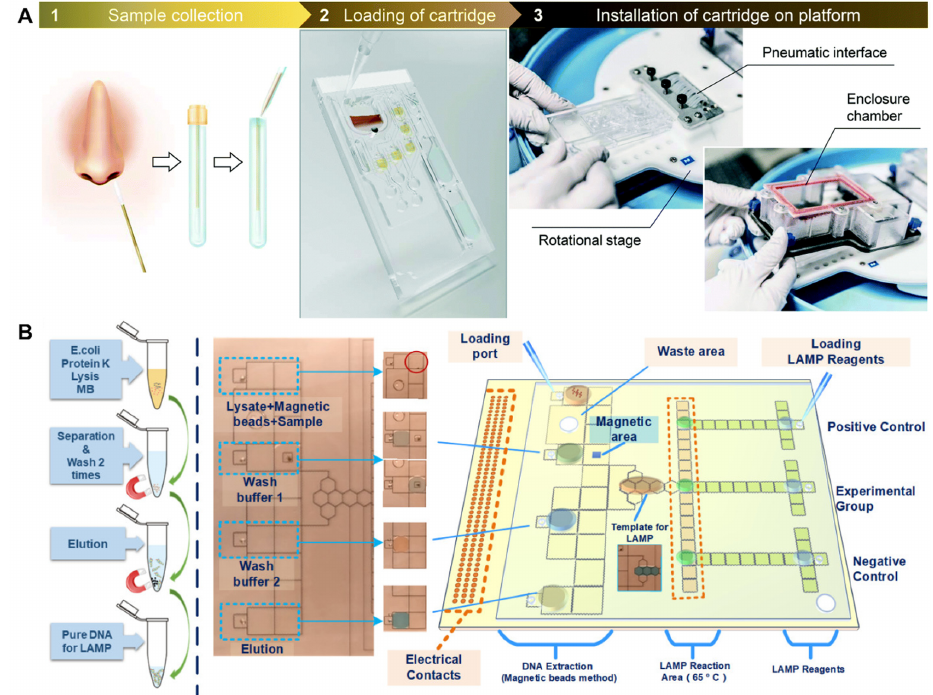
Figure 7. All-in-one microfluidic LAMP systems for COVID-19 detection. ( A ) Malic et al.’s centrifu- gal microfluidic LAMP system for COVID-19 detection. Reprinted with permission from [108]. Cop- yright 2022, Royal Society of Chemistry. ( B ) Hu et al.’s digital microfluidic LAMP system for COVID-19 detection. Reprinted with permission from [109]. Copyright 2022, Hu et al., under Crea- tive Commons 4.0 Attribution License.